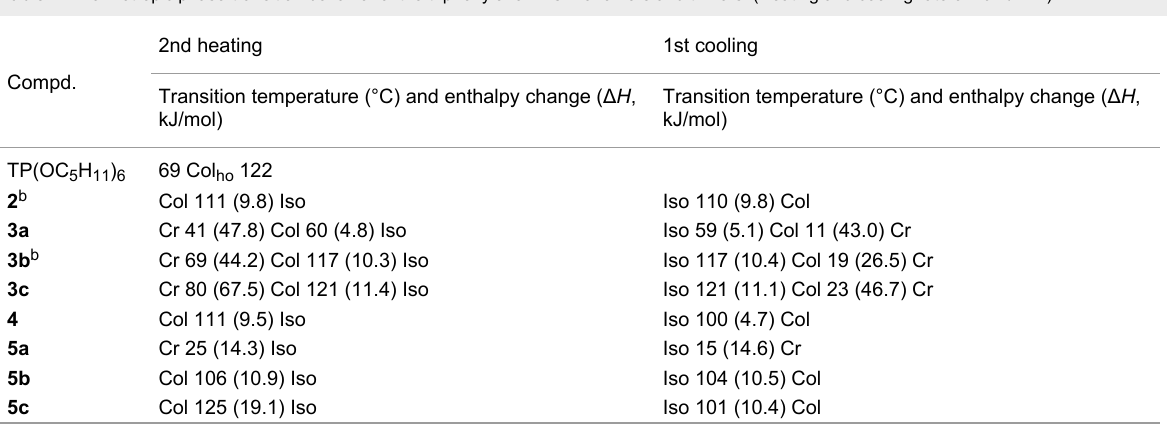
Table 1: Thermotropic phase-transition behavior of the triphenylene DLC monomers and trimers. (Heating and cooling rate of 10 K/min.) a